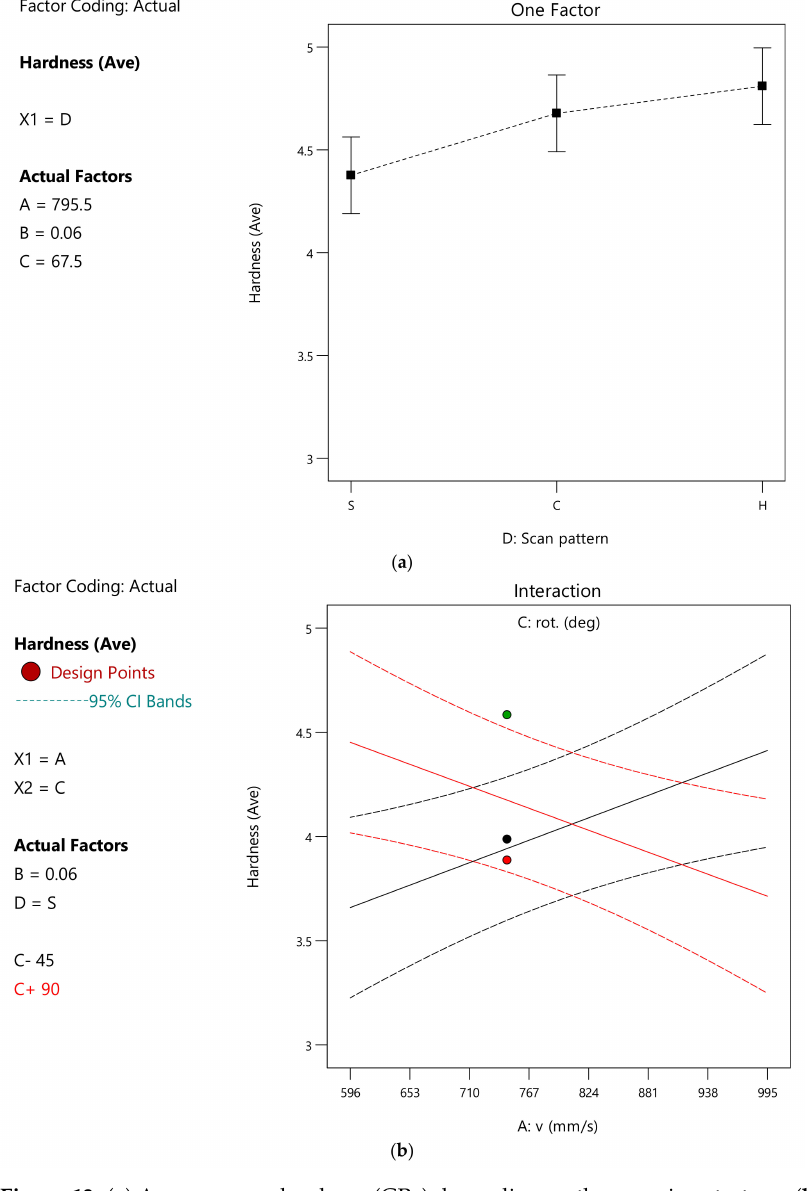
Figure 13. ( a ) Average nano-hardness (GPa) depending on the scanning strategy; ( b ) Influence of the interaction between the scanning speed and the interlayer rotation on the nano-hardness